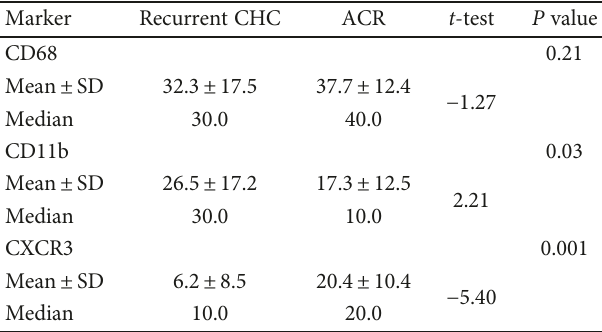
Table 3: Comparison between recurrent chronic hepatitis C (CHC) and acute cellular rejection (ACR) regarding the studied markers (CD68, CD11b, and